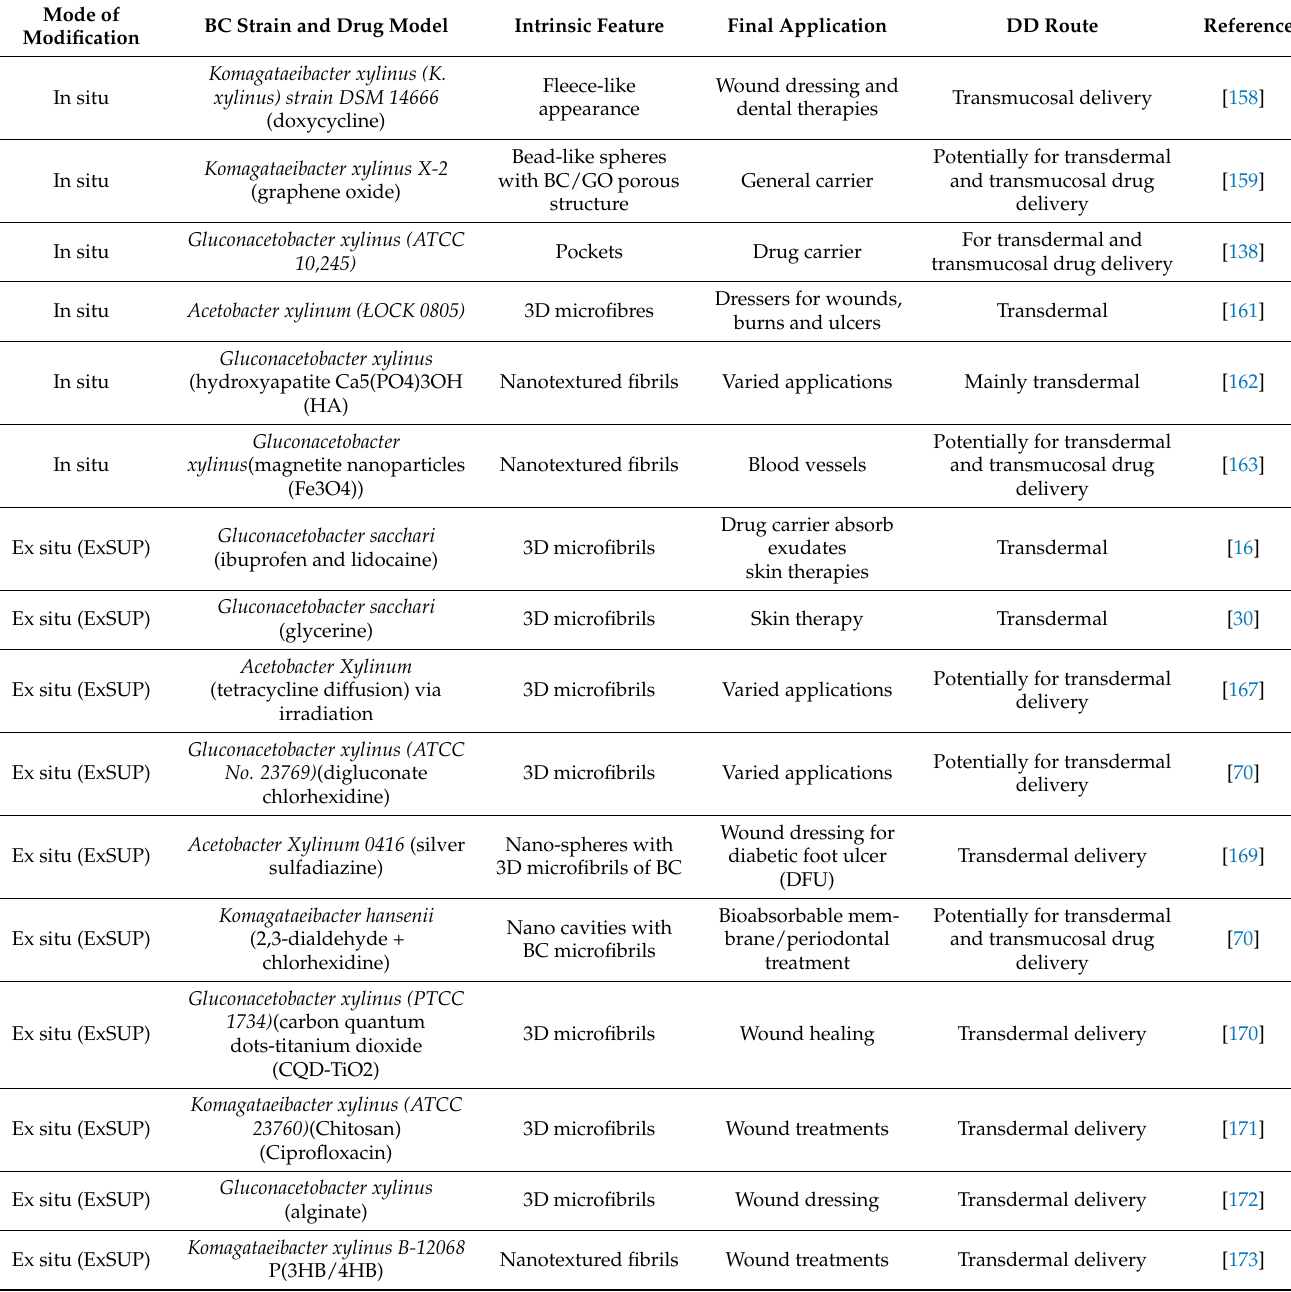
Table 5. Preparation methods and strategies for BC DDS